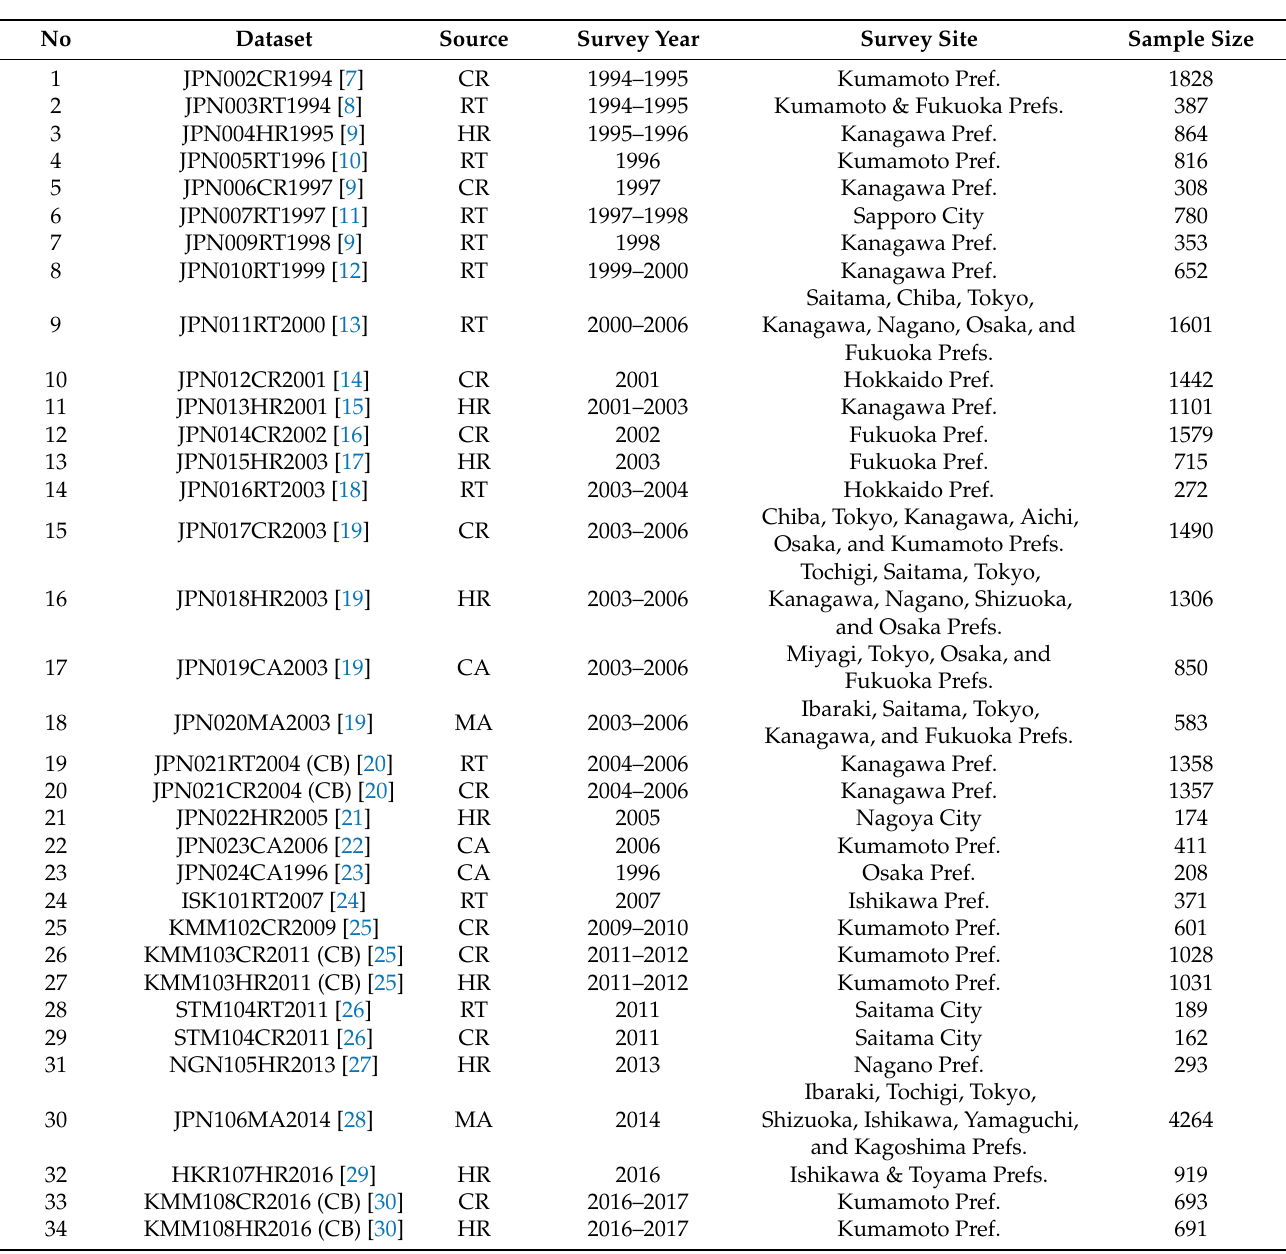
Table 1. Outline of